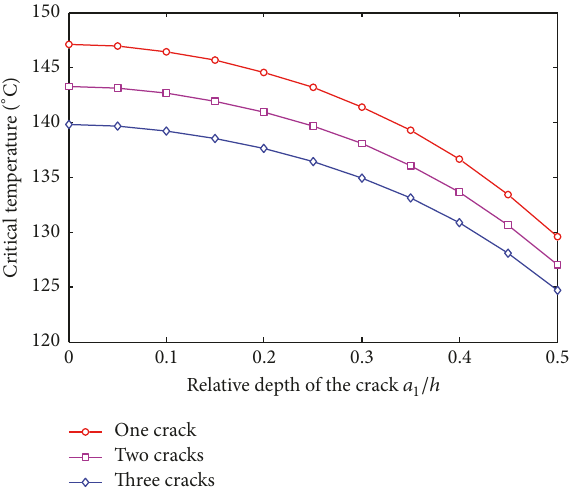
Figure8:Criticaltemperaturesofthebeamwithdifferentgeometric parameters of